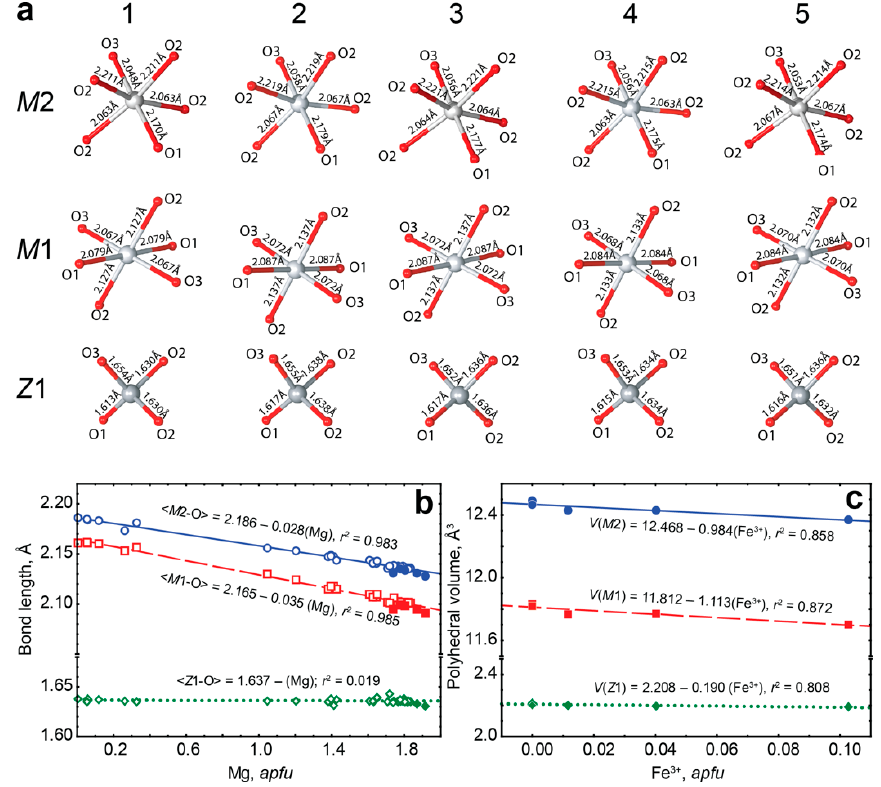
Figure 11. Geometry of coordination polyhedra in crystal structure of forsterites 1–5 ( a ), scatterplot of average < M 1-O>, < M 2-O> and < Z 1-O> bond lengths against magnesium content in olivine according to [61–64], and present data (filled squares and circles) ( b ), scatterplot of polyhedral volumes ( M 1, M 2 and Z 1) against ferric iron content ( c ).